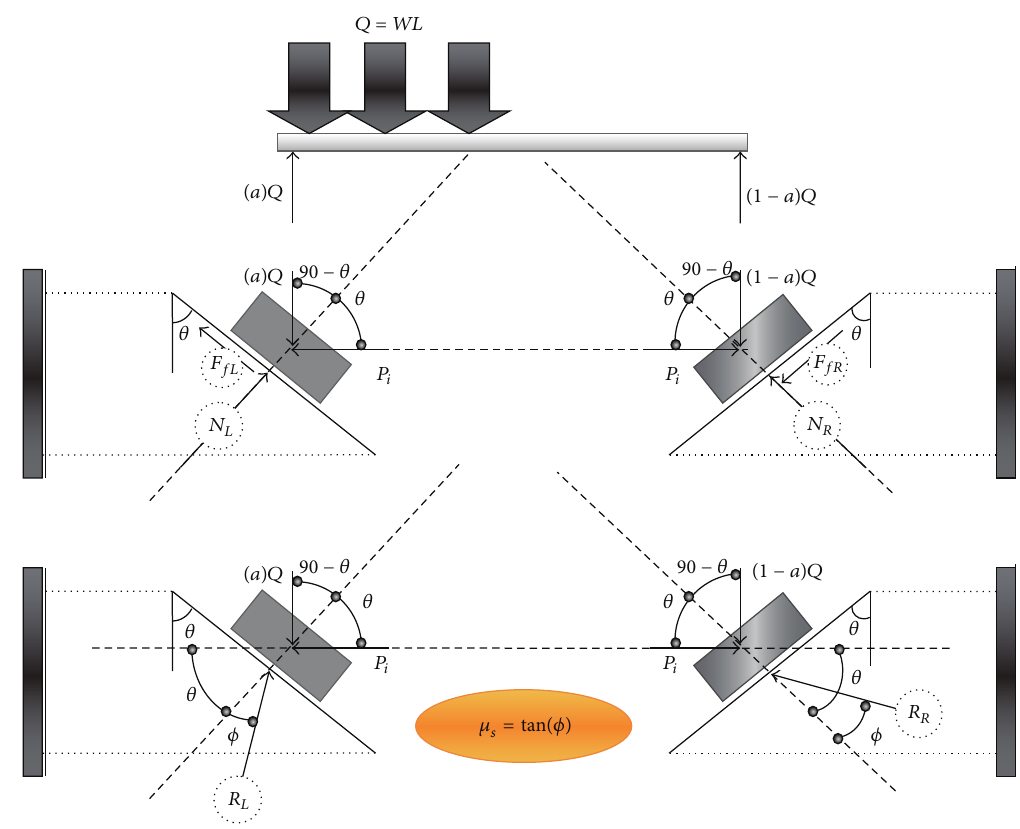
Figure 8: Free body diagram of beam with nonsymmetric gravity load before thermal effect (friction support).